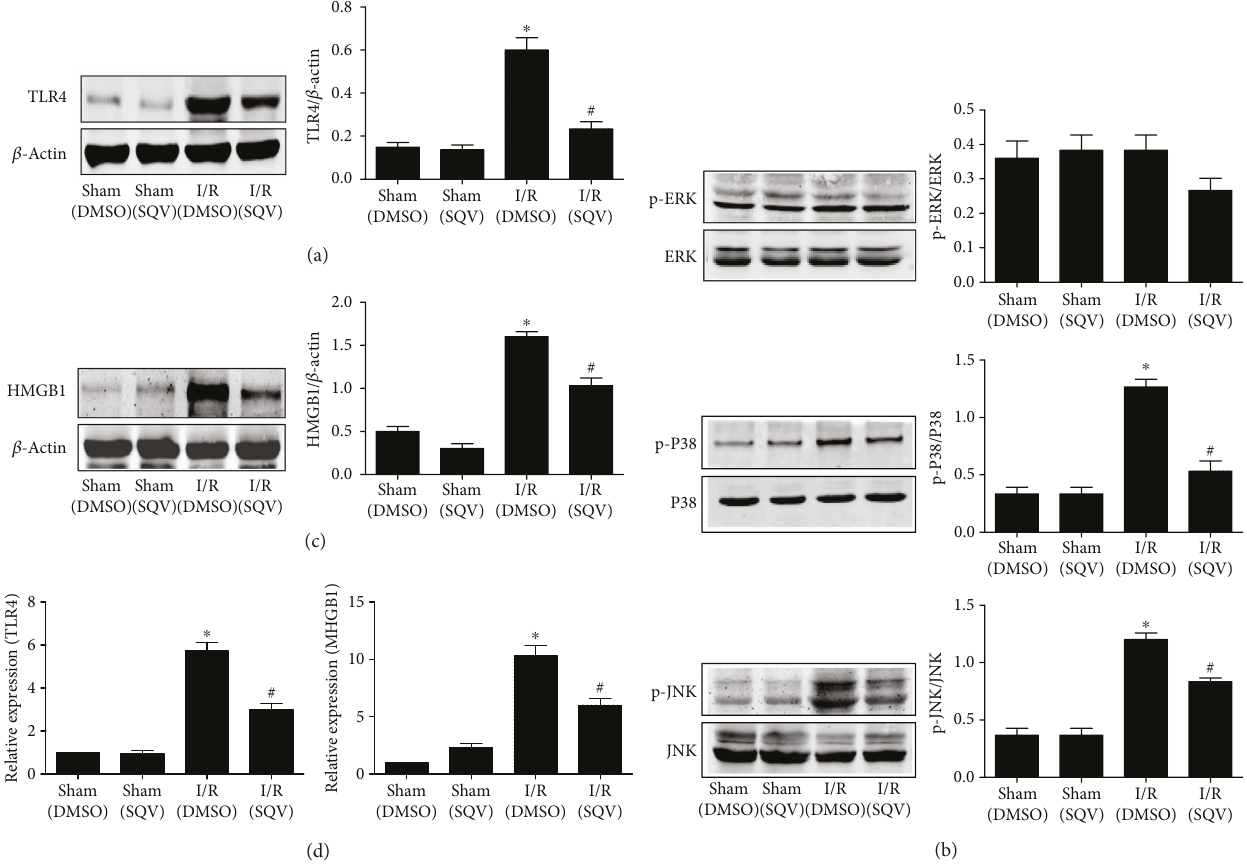
Figure 6: SQV attenuates HMGB1 and TLR4 expressions and a ff ects phosphorylation of MAPK signaling proteins in the lung tissue after liver I/R. Western blot was used to re fl ect the protein levels of TLR4 (a) and HMGB1 (b); the phosphorylation of ERK, P38, and JNK were also checked by immunoblotting analysis (d). qPCR was performed to con fi rm the expression level of TLR4 and HMGB1 (c). GraphPad values are presented as means ± SEM. ∗ P < 0 05 versus the Sham group; # P < 0 05 compared to the liver warm I/R